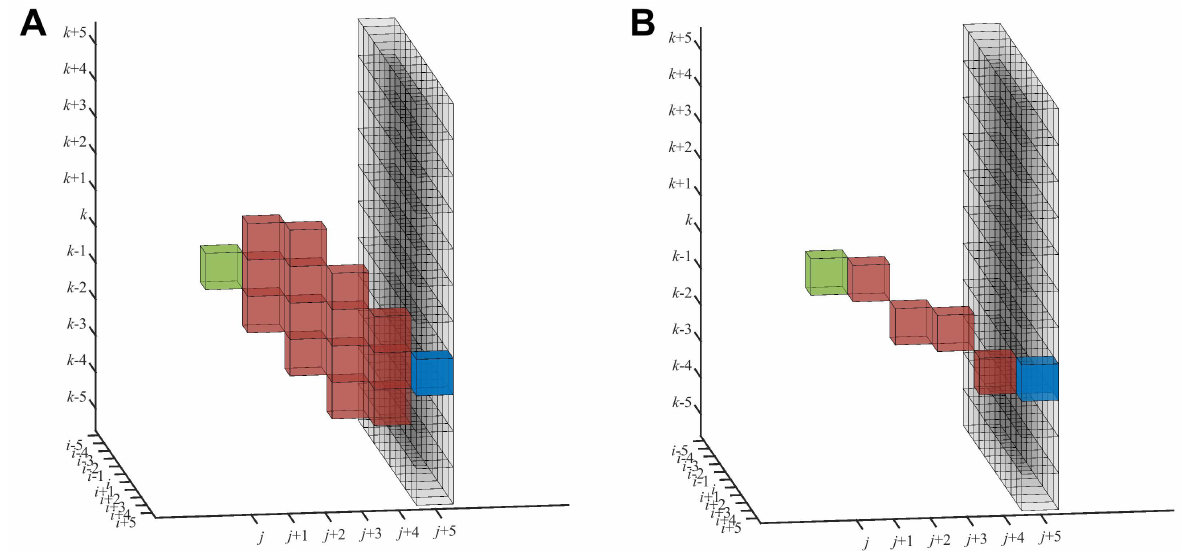
Figure 4. Two path density accumulation schemes were employed in the filament pattern enhance- ment and CFS tracing steps (Figure 1). ( A ) illustrates how the forward path density ( FPD ) of length l = 5 voxels accumulated from the voxel ( i , j , k ) (green) using the original DP approach [19] in Equation (1). The accumulation zone (red) is shown for a random target voxel ( i (cid:48) , j + l , k (cid:48) ) (blue), but the final FPD has been taken as the maximum among all potential targets (black) at the base of the search pyramid ( i − l ≤ i (cid:48) ≤ i + l , k − l ≤ k (cid:48) ≤ k + l , Equation (1)). ( B ) shows how the FPD accumulated with the alternative straight-line approach (also l = 5 voxels) in the CFS tracing (Figure